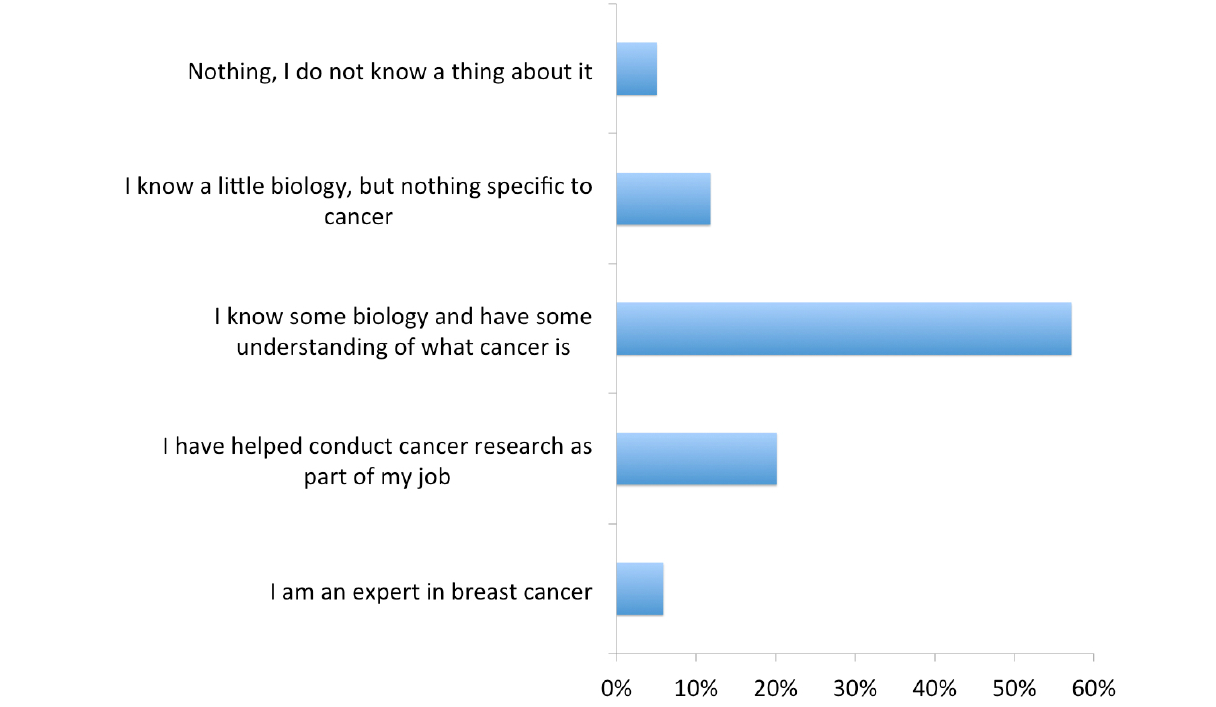
Figure 10. Levels of breast cancer knowledge among